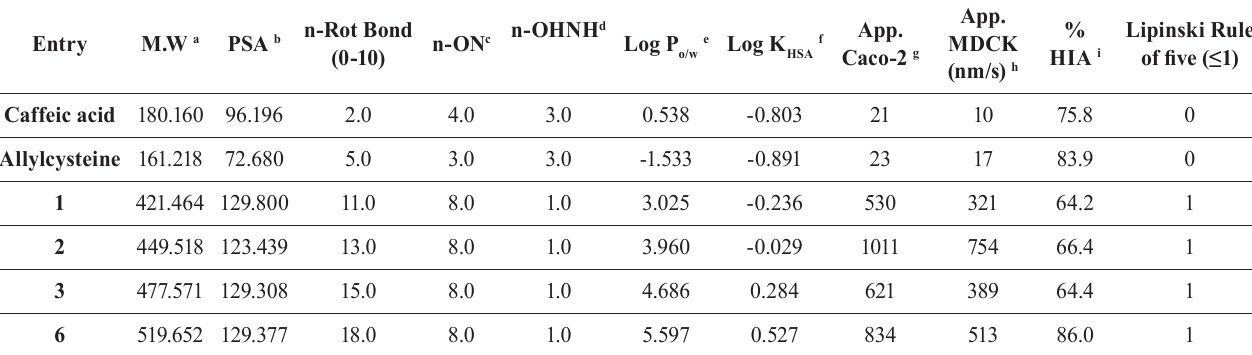
TABLE IV - In silico pharmacokinetic and ADME indices of conjugates 1-3,6